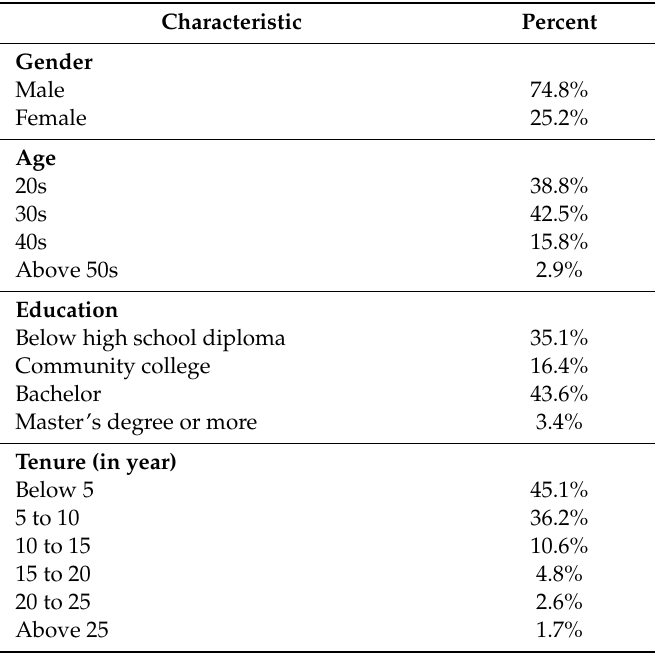
Table 1. Descriptive characteristics of our